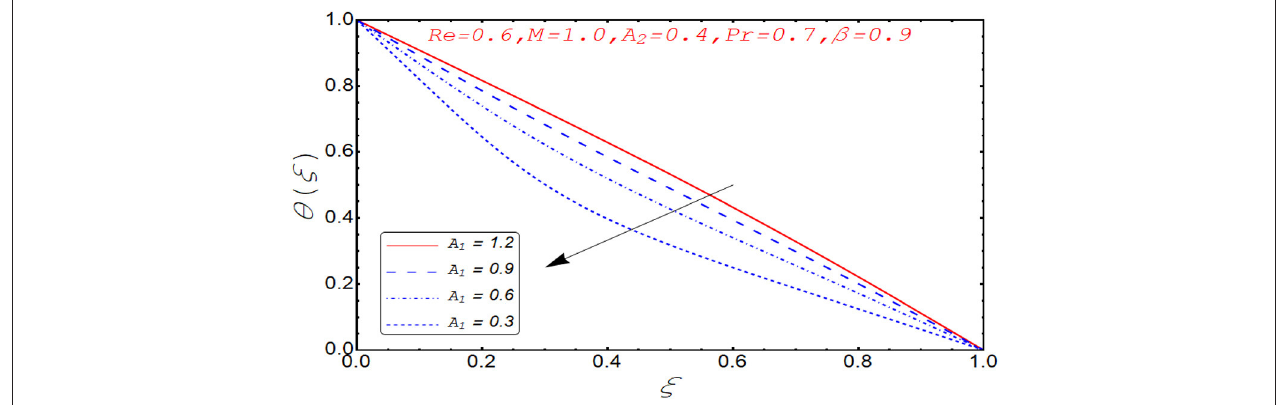
FIGURE 15 | Behavior of θ ( ξ ) for different A 1 .